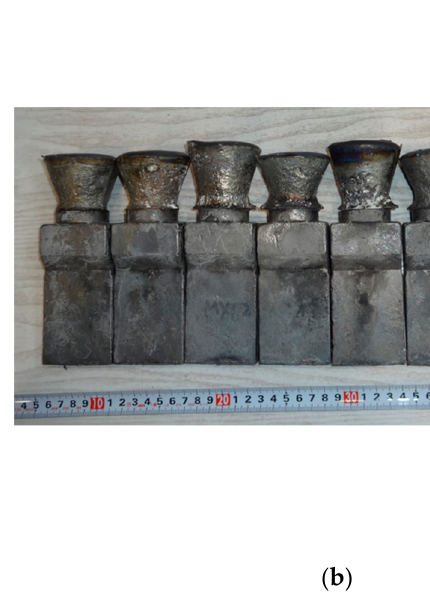
Figure 1. ( a ) Schematic of the split metal mold and the shape of the cast material. ( b ) Photographs of the fabricated cast materials.